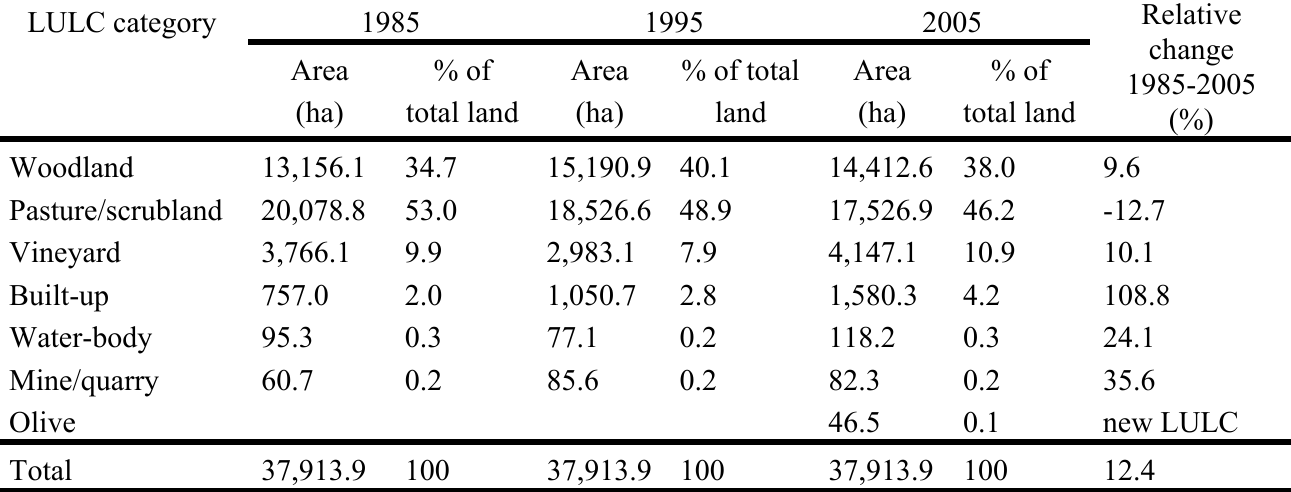
Table 5. Summary of Area statistics based on PCC maps for 1985, 1995 and